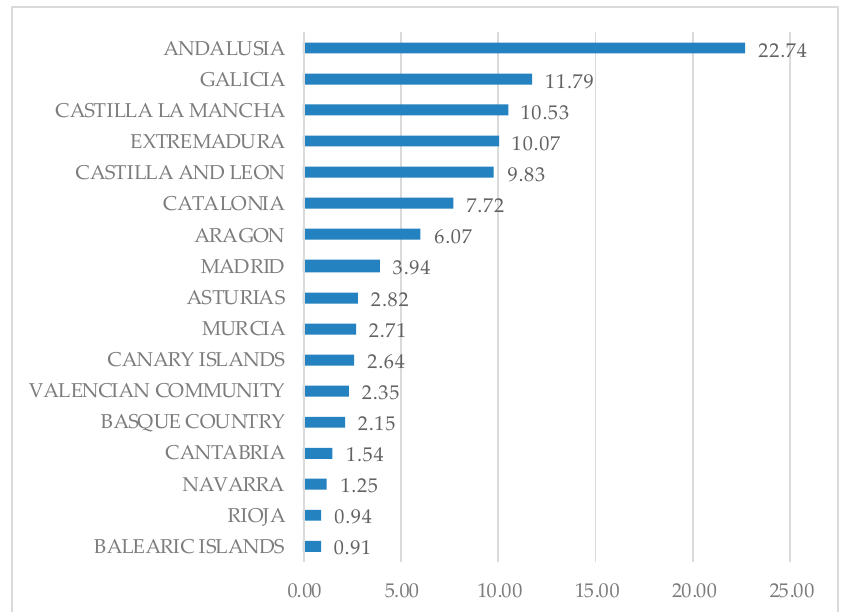
Figure 2. EAFRD percentage distribution for the period 2007–2013 (Source: Own elaboration from data published by the Ministry of Agriculture, Fisheries, and Food).